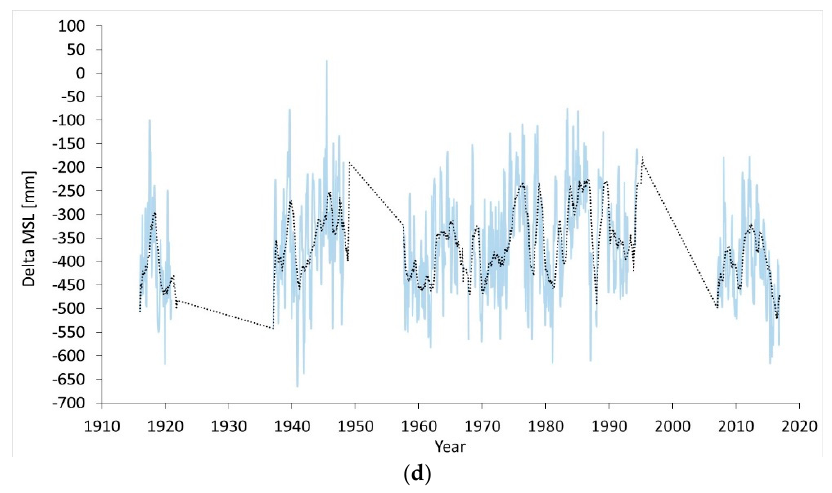
Figure 11. Comparison of the MSL of Fremantle and Aden ( a ) and their differences ( b ). Comparison of the MSL of Fremantle and Karachi ( c ) and their differences ( d ).